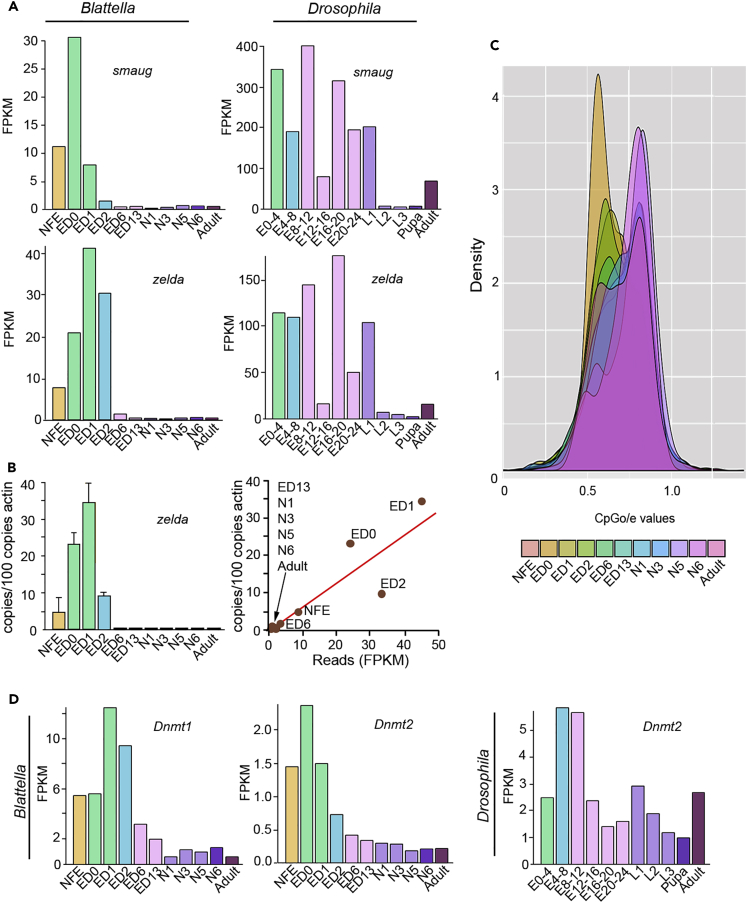
Gene Expression and Methylation during the Maternal to Zygotic Transition in Blattella germanica and Drosophila melanogaster(A) Reads-based expression of smaug and zelda along the different stage-libraries.(B) Left: qRT-PCR-based expression of zelda along the same stages in B. germanica; each value represents three biological replicates and it is represented as copies of zelda mRNA per 100 copies of BgActin-5c mRNA (mean ± SEM). Right: Representation of the FPKM and qRT-PCR values of expression of zelda in the stages studied and the regression line obtained.(C) The CpGo/e distribution of the differentially expressed genes in each stage-library of B. germanica.(D) Expression of DNA methyltransferase Dnmt1 and the tRNA methyltransferase Dnmt2, along the different stage-libraries. In A, B, and D, identical bar colors indicate equivalent developmental periods, according to the criteria summarized in Table S2.